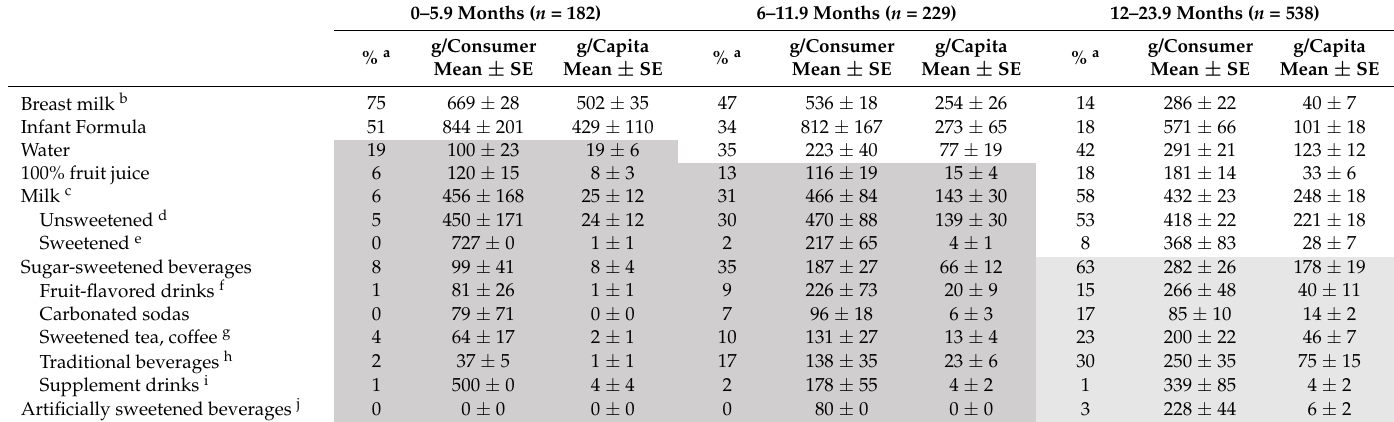
Table 3. Consumption of appropriate and inappropriate milk and beverages among Mexican infants and toddlers in the ENSANUT 2012.